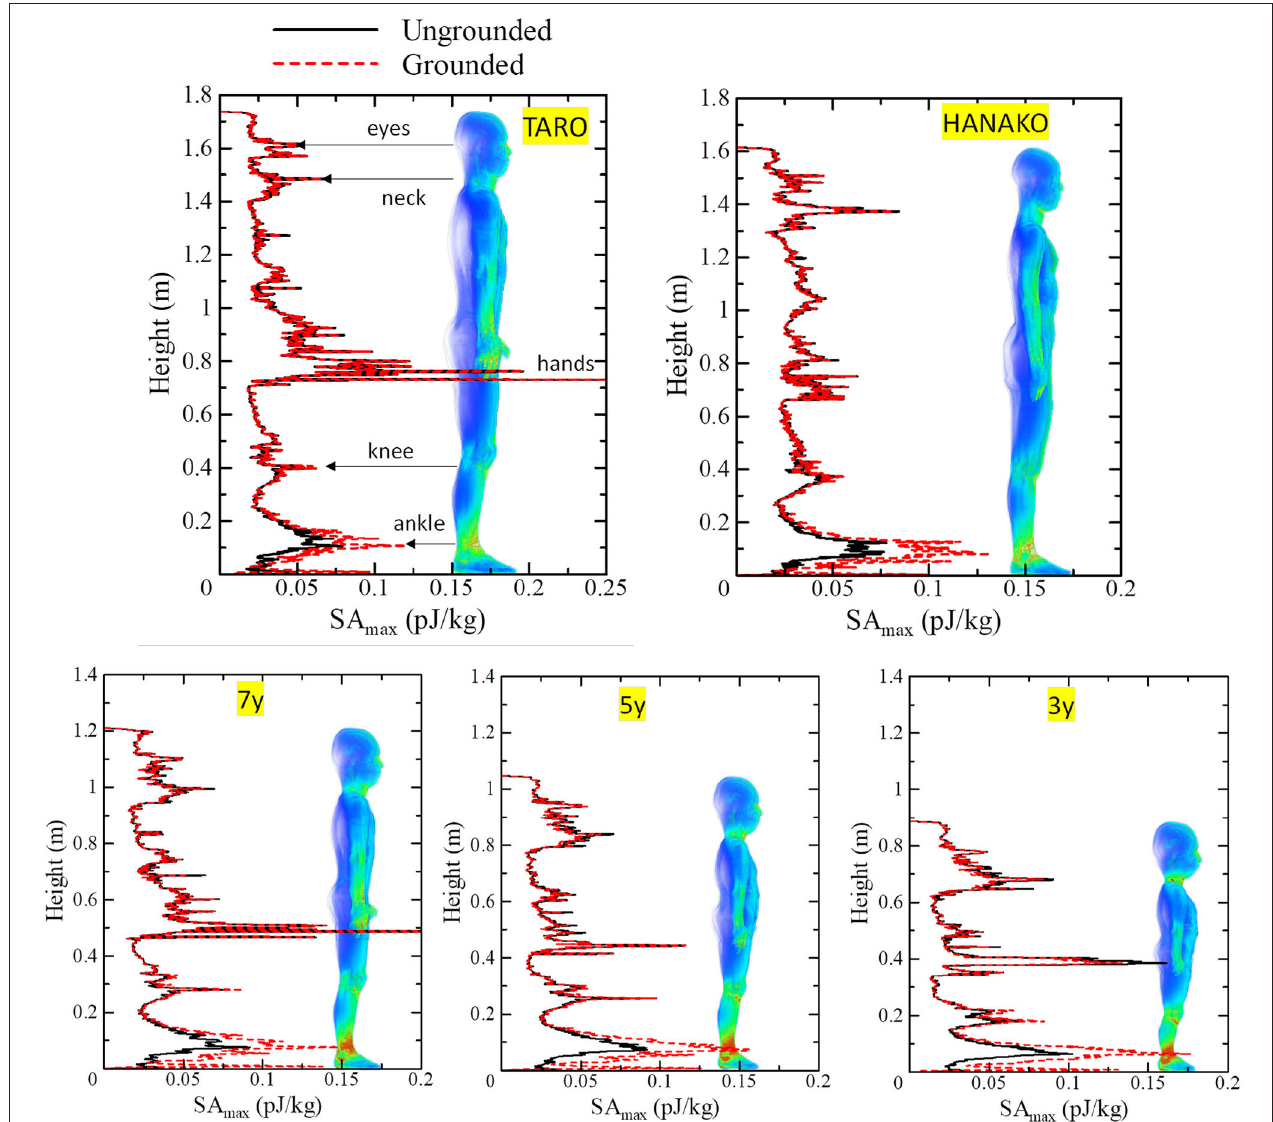
FIGURE 10 | Maximum SA at each height for various human models for 1 V/m electric field